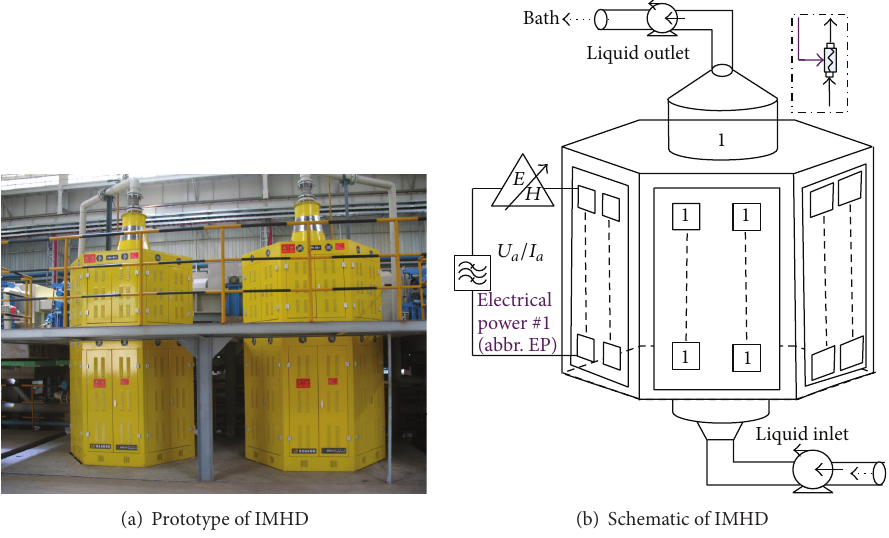
Figure 2: The schematic diagram of the IMHD which is EP in Figure